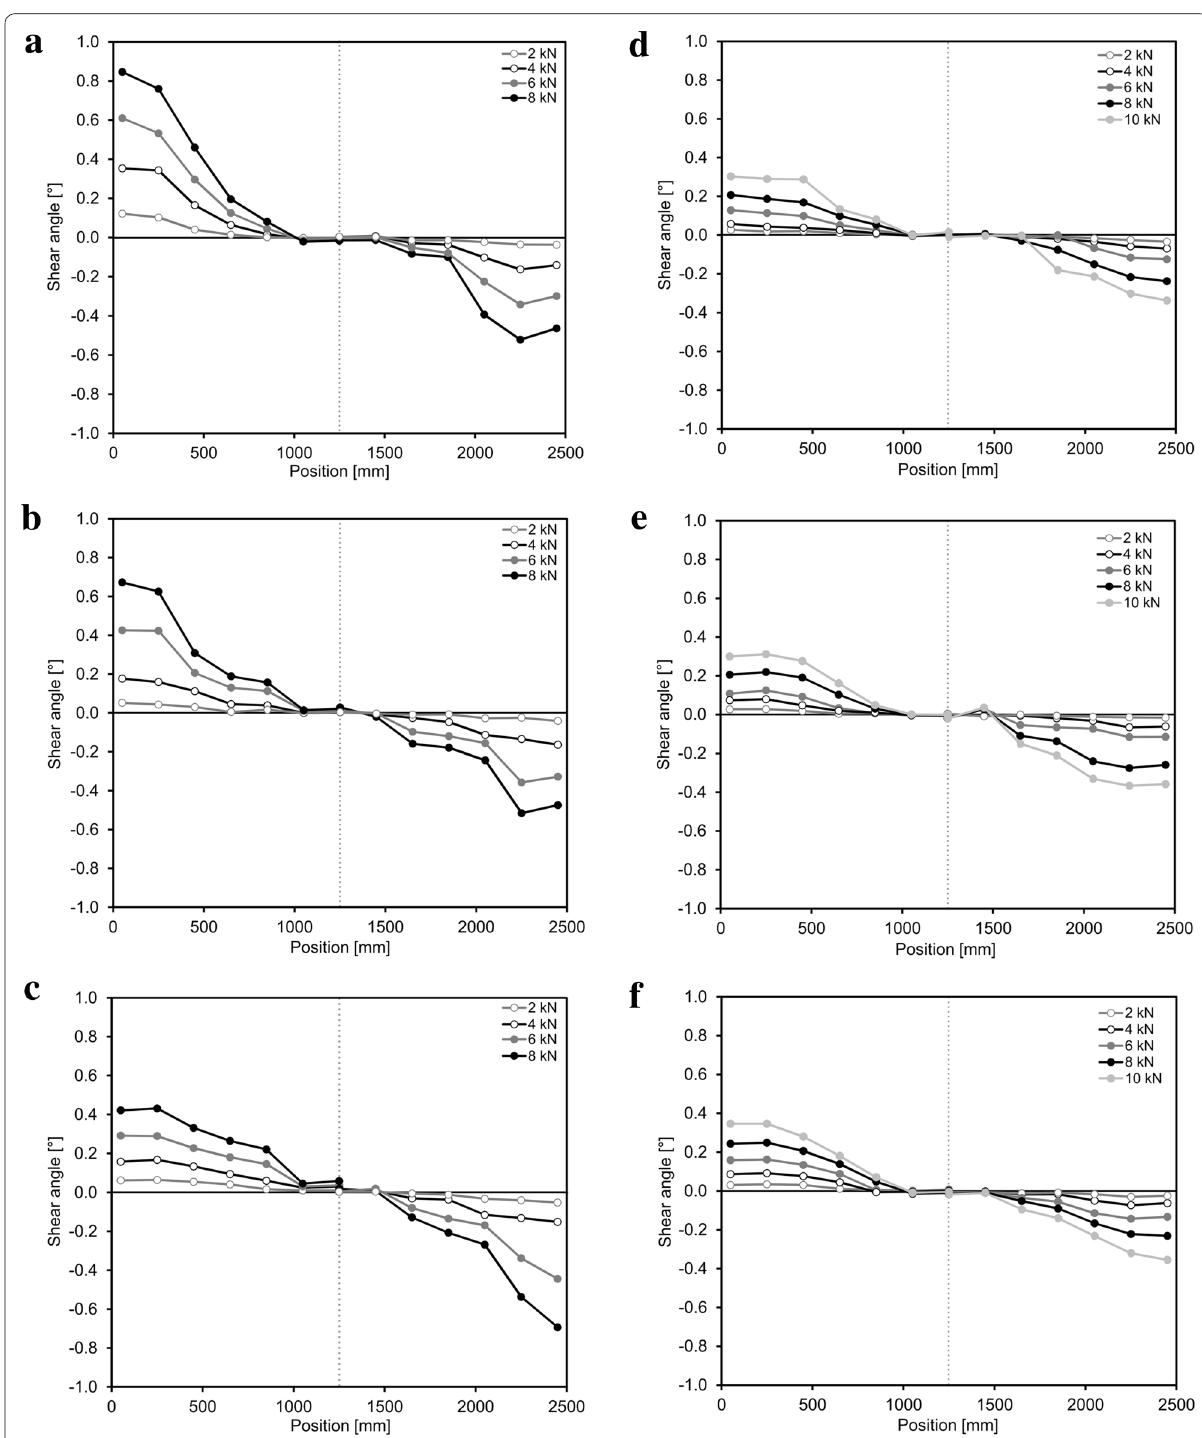
Fig. 13 Shear angle between the lower and upper panel, along specimens; a S-1, b S–2, c S-3, d D-1, e D-2 and f